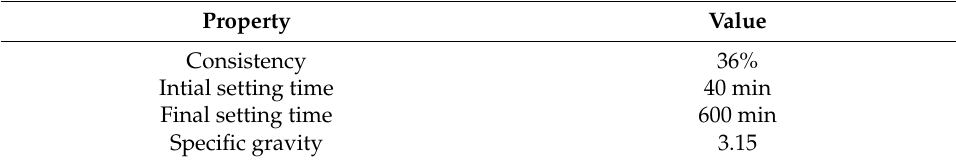
Figure 2. ( a ) Marquisette net 5 mm mesh, ( b ) sandfly net small mesh 5 mm mesh, and ( c ) sandfly net big mesh 10 mm mesh. Table 1. Physical properties of OPC cement (53 grade).